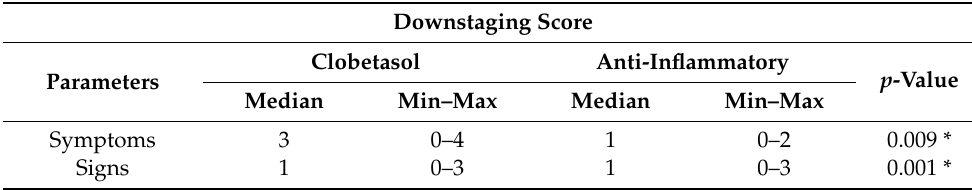
Table 4. Comparison of downstaging of symptoms and signs between the clobetasol group and the anti-inflammatory